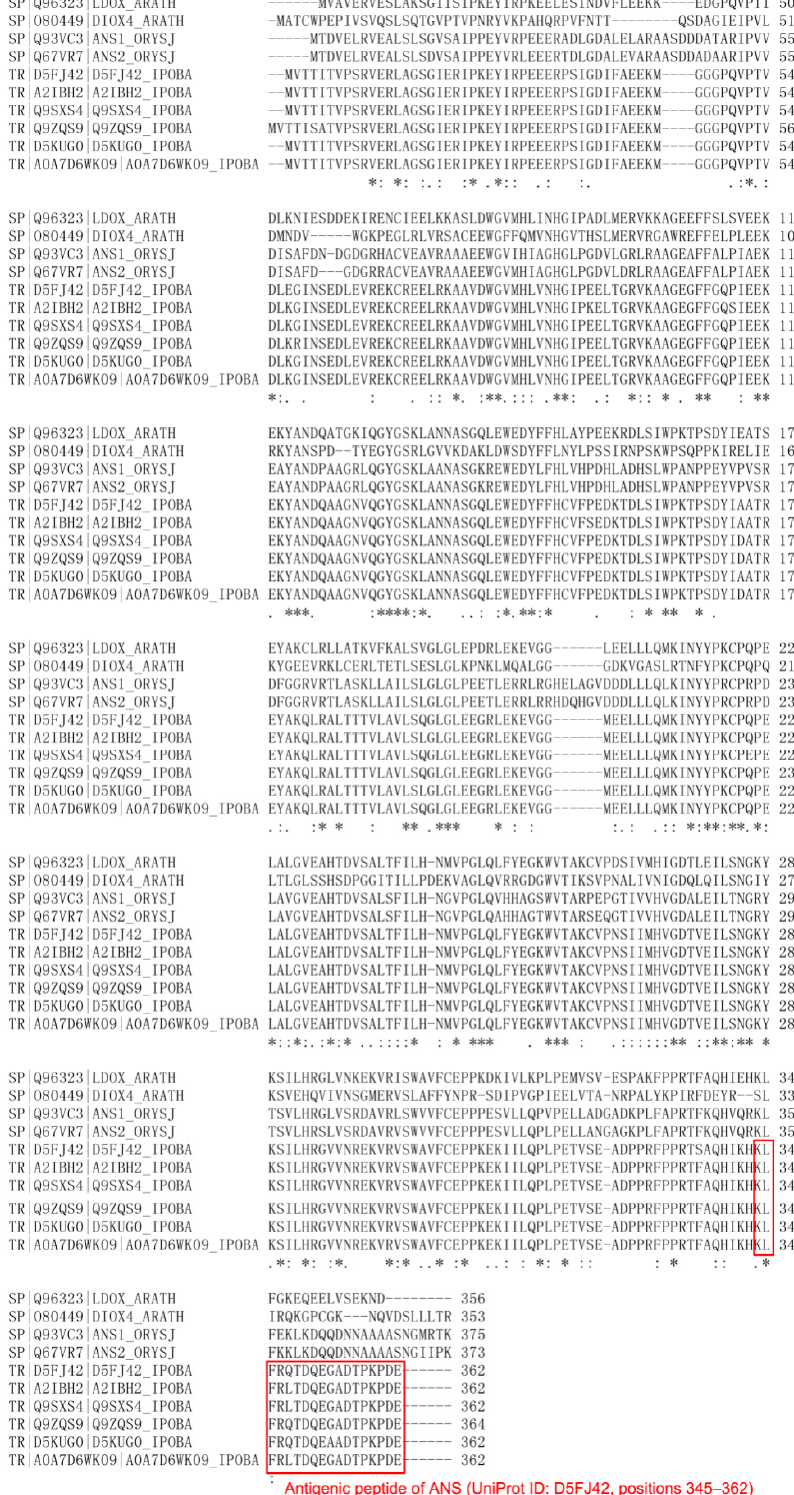
Figure A3. Sequence analysis of ANS. The antigenic peptides of ANS are marked with red frames. Align protein sequences with the Clustal Omega program (https://www.uniprot.org/align/, ac- cessed on 25 February 2021) to view their characteristics alongside each other. The asterisks (*) represent significant amino acid residue identity, and the dots (:/.) represent amino acid residue similarity.